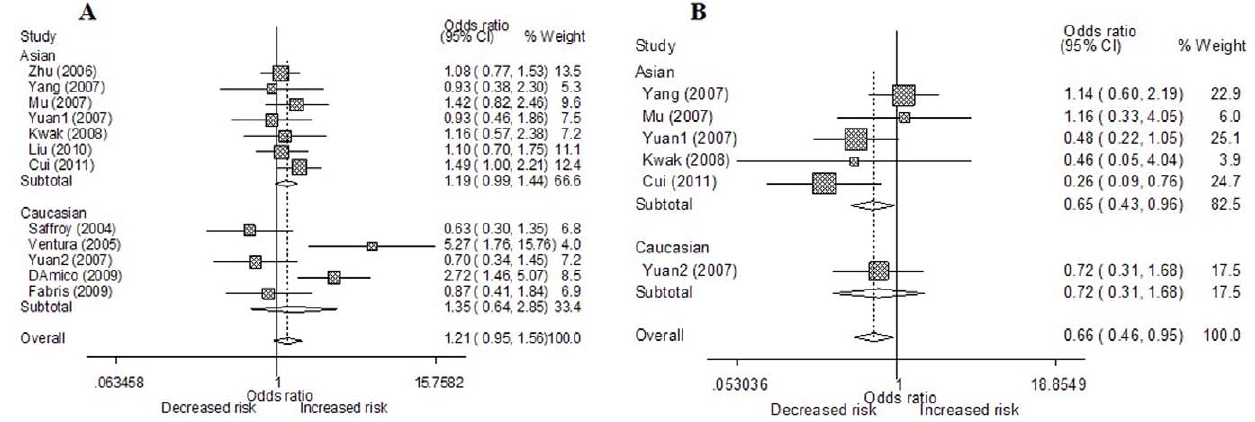
Figure 2. Forest plots of MTHFR gene polymorphisms and HCC risk. A Forest plots of MTHFR C677T polymorphism and HCC risk in subgroup analysis by ethnicity using a random-effect model (contrast TT vs. CC); B Forest plots of MTHFR A1298C polymorphism and HCC risk in subgroup analysis by ethnicity using a fixed-effect model (CC vs. AA).